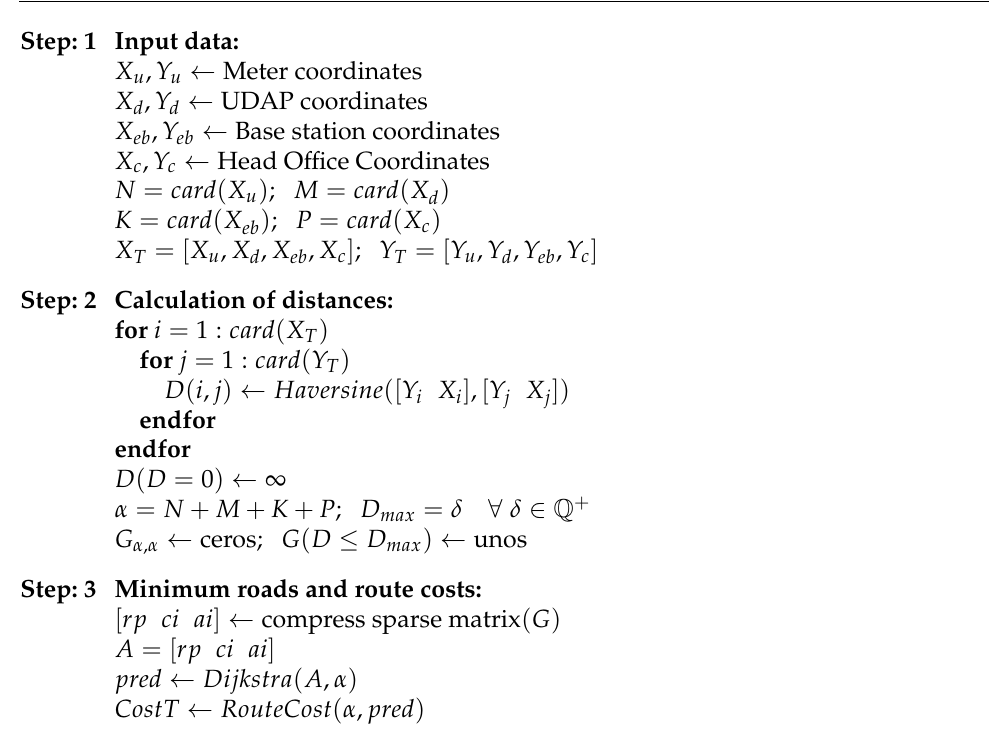
Algorithm 1 Shortest Routes in a Wireless